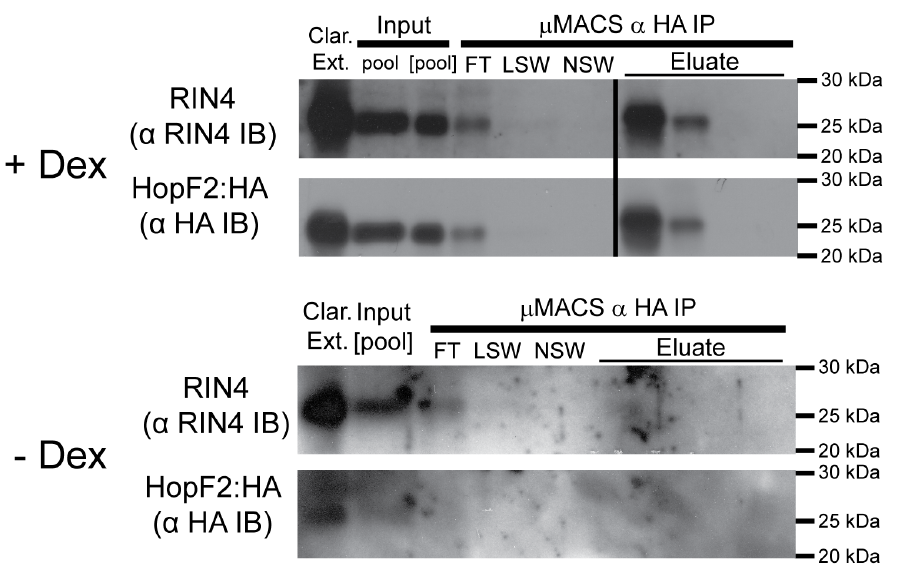
Fig. 2. HopF2 and RIN4 co-purifty during immunoaffinity purification from high-molecular weight FPLC fractions. High Mr fractions containing HA immunoreactive (V e 36–46 ml) bands were pooled (input, pool) and concentrated for one hour in a 10,000 Da Mr cutoff concentrator (input, [pool]). Concentrated pooled fractions were incubated with anti-HA magnetic resin ( m MACS), immobilized, flow through (FT) collected and resin washed with low salt (LSW), no salt (NSW) buffer then eluted over four fractions with 0.1 M NH 4 OH. Samples were resolved by SDS-PAGE and immunoblotted (IB) with a (RIN4) immunosera and a (HA) IgG. All bands are from the same blot exposure. Blots were cropped to remove molecular weight standards between lanes containing NSW and eluate fractions. Blots of purifications from -DEX tissue were overexposed relative to blots from + DEX purifications. Results are representative of 3 independent